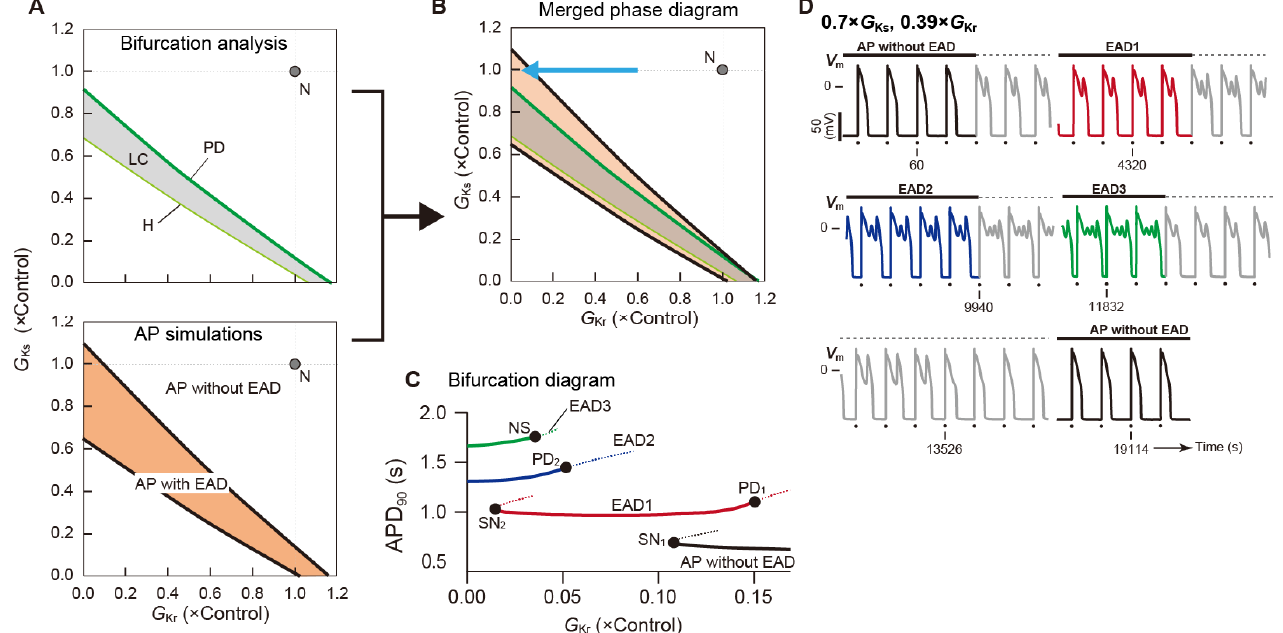
Figure 10. Bifurcation phenomena and action potential behaviors observed in the Kurata model [112] of a human ventricular myocyte. ( A ) A two-parameter bifurcation diagram on the ( G Kr , G Ks )- parameter plane ( top ) obtained using MATCONT [154] and a phase diagram ( bottom ) obtained by AP simulations. The maximum conductances of the rapid ( G Kr ) and slow ( G Ks ) components of delayed rectifier K + channel currents are expressed as normalized values, i.e., ratios to the control values. In the two-parameter bifurcation diagram ( top ), the symbols H and PD represent the loci of parameter sets that cause the Hopf bifurcation of an equilibrium point and period-doubling bifurcation of a limit cycle (LC), respectively. The gray region indicates the area of parameters in which a stable LC can be observed. On the other hand, in the phase diagram ( bottom ), the orange and white regions represent parameter regions in which an AP with and without EAD, respectively, can be observed in the Kurata model. The gray point with the symbol N indicates the control condition with the normal G Kr and G Ks . ( B ) A merged phase diagram. ( C ) A one-parameter bifurcation diagram of APD at 90% repolarization (APD 90 ) in each AP response as a function of G Kr ; see the blue arrow in panel ( B ), which indicates the change in G Kr with the fixed normal G Ks (1). The solid and dashed lines in ( C ) represent stable and unstable AP responses, respectively. SN: saddle-node bifurcation; EAD1–3: AP with 1–3 EAD(s); PD: period-doubling bifurcation. NS: Neimark–Sacker bifurcation. ( D ) An example of tetra-stable AP dynamics in the Kurata model at 0.39 × G Kr with 0.70 × G Ks . Colored and grey lines indicate the steady-state and transient responses, respectively. Dots indicate the application of current pulses. Pacing cycle length = 2 s. Each panel was modified from [85,130].